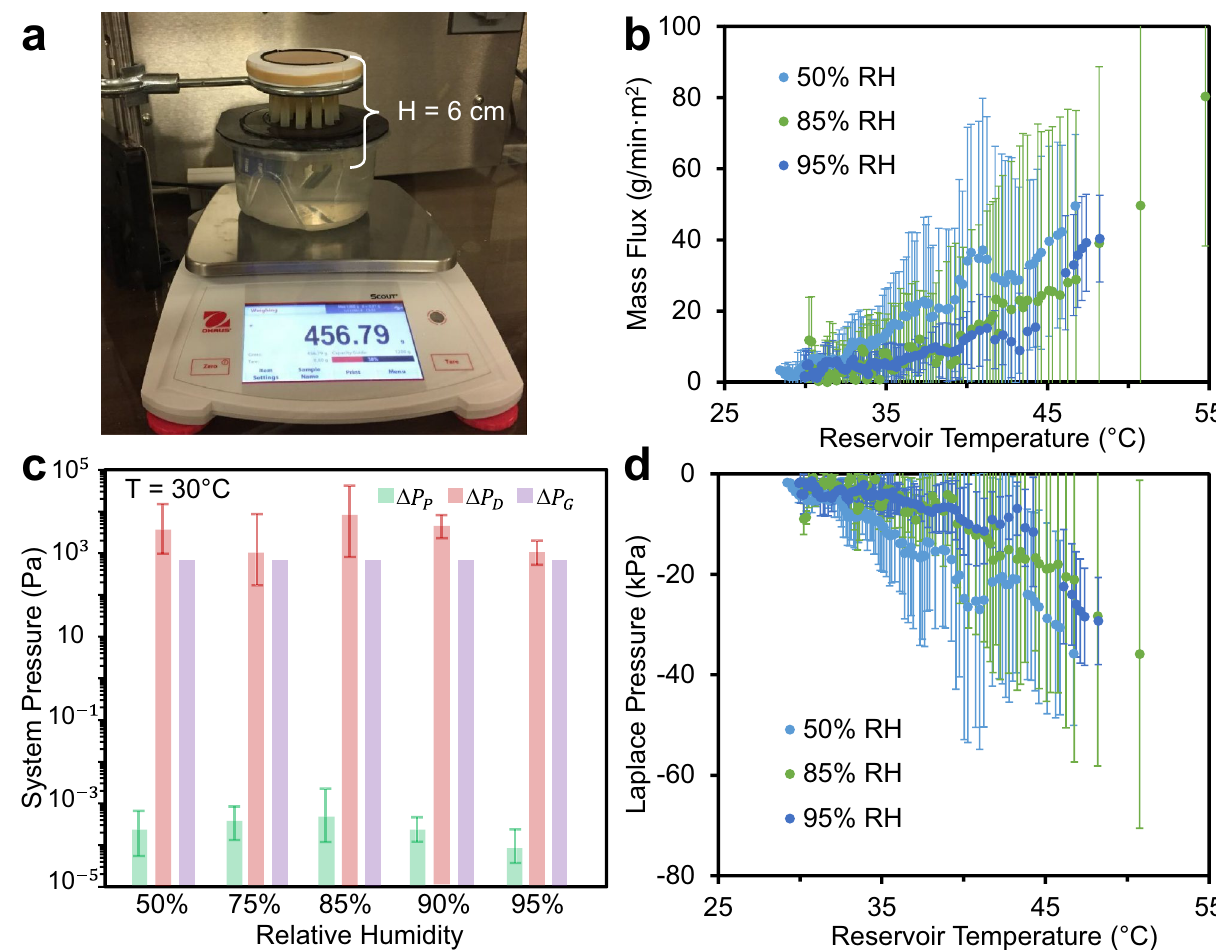
Figure 1. Demonstration of transpiration in a short (6 cm), scalable tree. ( a ) Photograph of the experimental setup, where 19 parallel tubes pump water from a bottom reservoir to an upper synthetic leaf. The transpiration rate is tuned by changing the ambient humidity using an environmental chamber and measured using a mass balance. ( b ) Transpiration mass flux of synthetic short trees as a function of the water temperature and ambient humidity. The pre-boiled water in the reservoir is cooling over the course of the experiment, such that time progresses from right-to-left along the x-axis and each data set represents a 3 h period. ( c ) Estimated pressure drops across the synthetic tree, where Δ P P represents viscous losses along the tube array, Δ P D is the pressure drop across the wetted leaf, and Δ P G is the hydrostatic pressure column in each tube. Values of Δ P P and Δ P D were calculated to correspond to the flow rate measured at a reservoir temperature of 30 °C. ( d ) Estimated Laplace pressure as a function of the water temperature and ambient humidity, expressed as the sum of the three pressure drops found in (c). All values in (b–d) correspond to an average of three trials with error bars of one standard